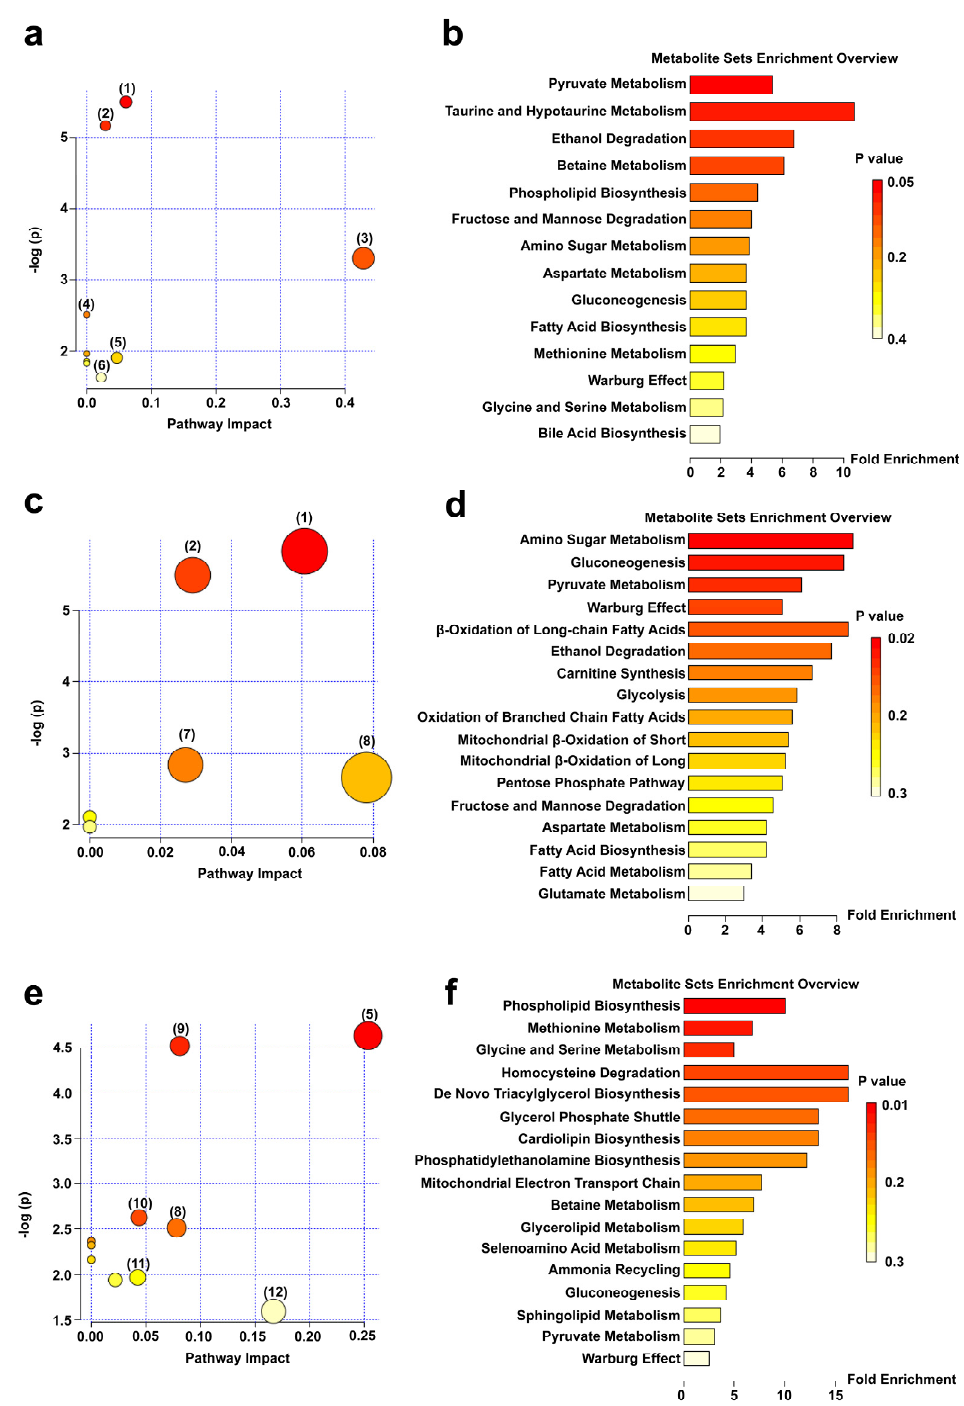
Figure 5. Metabolic pathway maps and enrichment overview maps of serum differentially expressed metabolites in mice. ( a ) Metabolic pathways and ( b ) Overview of metabolite enrichment in HC vs. DSS group; ( c ) Metabolic pathways and ( d ) Overview of metabolite enrichment in DSS vs. PM groups; ( e ) Metabolic pathways and ( f ) Overview of metabolite enrichment in DSS vs. SPM groups. The numbers in the metabolic pathway maps represent as follows: (1) Pyruvate metabolism; (2) Glycoly- sis/gluconeogenesis; (3) Taurine and hypotaurine metabolism; (4) Fructose and mannose metabolism; (5) Glycine, serine, and threonine metabolism; (6) Primary bile acid biosynthesis; (7) Starch and su- crose metabolism; (8) Pentose and glucuronate interconversions; (9) Glycerophospholipid metabolism; (10) Glycerolipid metabolism; (11) Glyoxylate and dicarboxylate metabolism; (12) Aminoacyl-tRNA